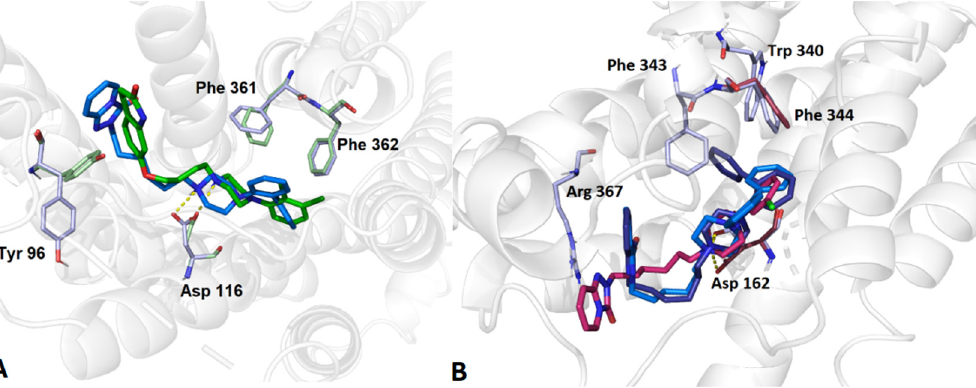
Figure 2. ( A ): Binding modes of 7b (blue) and aripiprazole (green) in 5-HT 1A R; ( B ): binding modes of 7b (blue) and 7a (red) in 5-HT 7 R. The yellow dash-lines indicate the hydrogen bonds. Key residues are colored sticks.